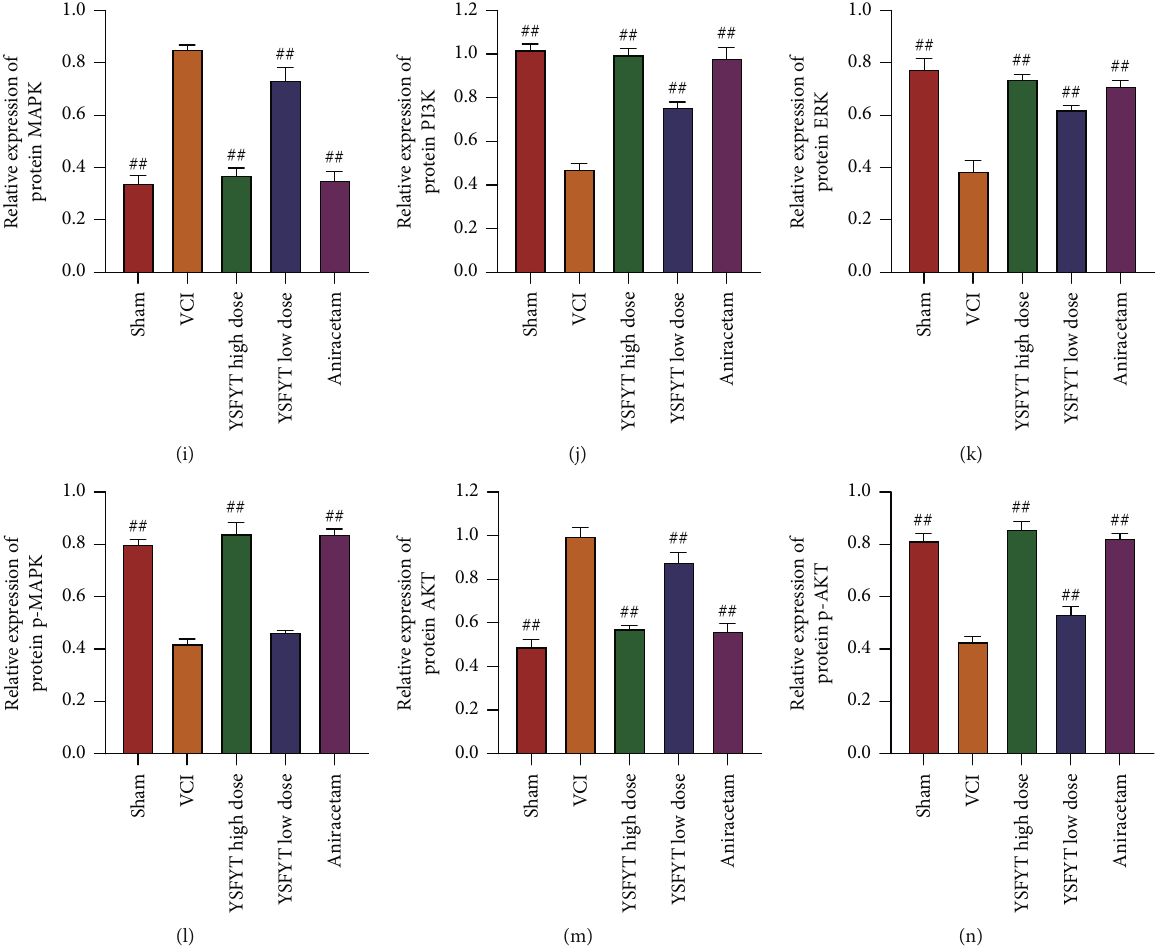
Figure 8: Western blot detection of protein expressions. (a) Results of protein bands. (b – n) Relative protein expressions of GAP43, MAP-2, SYP, PSD95, NR2B, BDNF, TrkB, MAPK, p-MAPK, ERK, PI3K, AKT, and p-AKT. # p < 0 : 05 ; ## p < 0 : 01